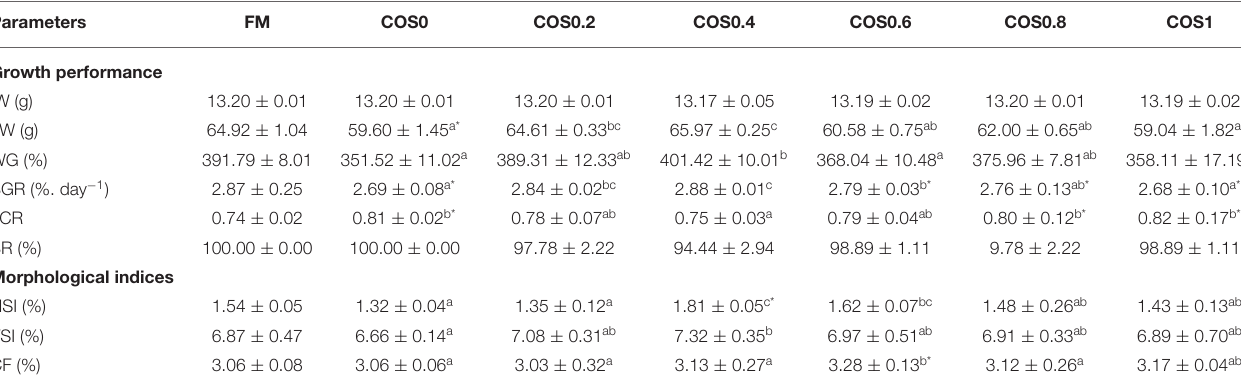
TABLE 4 | Growth performance and morphological indices of hybrid grouper fed with experimental diets for 8 weeks. Parameters